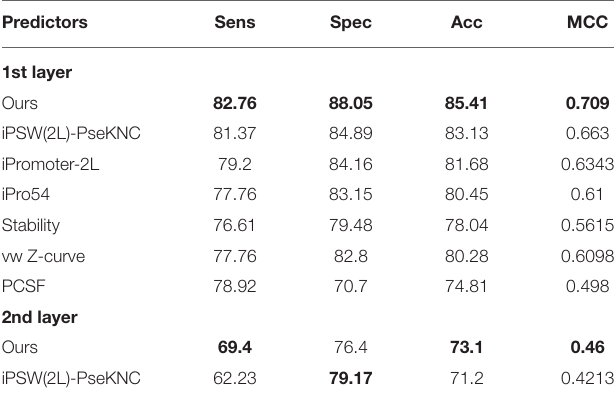
TABLE 4 | Comparison with previous predictors on the same benchmark